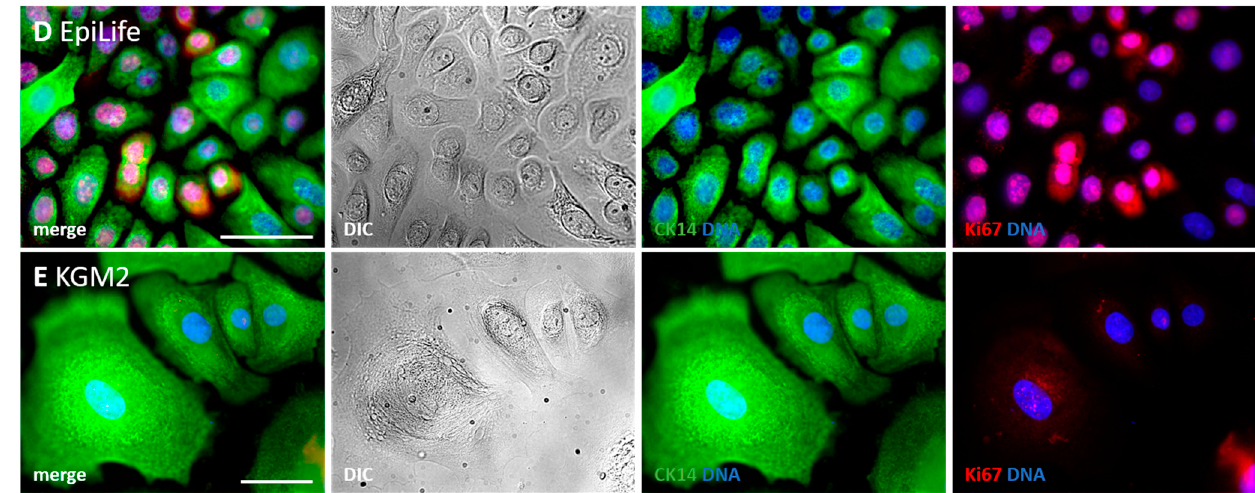
Figure 5. Comparison of KGM2 and EpiLife as secondary media. ( A ) Graph showing the days (d) until the keratinocytes achieve the “circle condition”. Keratinocytes were growing either in EpiLife or KGM2 media following the initial outgrowth in MEFCM. Overview DIC image of confluent keratinocytes cultured in either secondary EpiLife ( B ) or KGM2 ( C ) media. Notice the terminally differentiated keratinocytes in the KGM2 ( C ) with a large, polygonal-shaped cytoplasm. High magnification image of keratinocytes grown in MEFCM + EpiLife medium ( B ′ – B ‴ ) and MEFCM + KGM2 ( C ′ – C ‴ ) in a DIC image, immunostained for CK5,10,14 (green) and nuclear marker DAPI (blue). Ki67 staining (red) for the visualization of dividing keratinocytes either in Epilife medium ( D ) or KGM2 ( E ). Keratinocytes were counterstained for CK14 (green) and nuclear marker DAPI (blue). N = number of single, independent experiments. Scale bar: 400 µm ( B , C ), 50 µm ( B ′ – B ‴ , C ′ – C ‴ , D , E ).